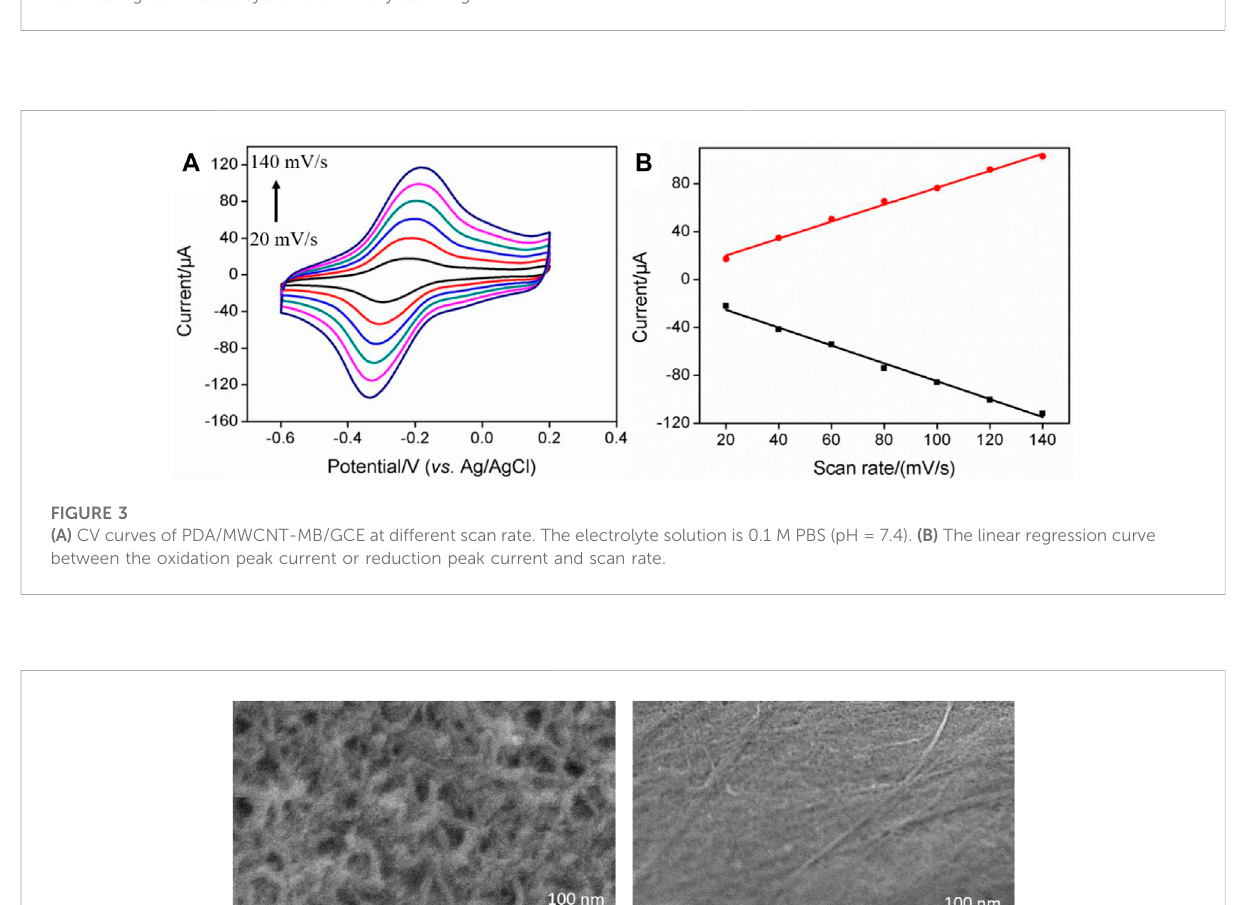
FIGURE 2 (A) CVandDPV (inset)curvesobtained ondifferentelectrodes inPBSelectrolyte (0.1M,pH=7.4). (B) CVcurvesobtained onPDA/MWCNT-MB/ GCE during continuous cyclic voltammetry scanning.